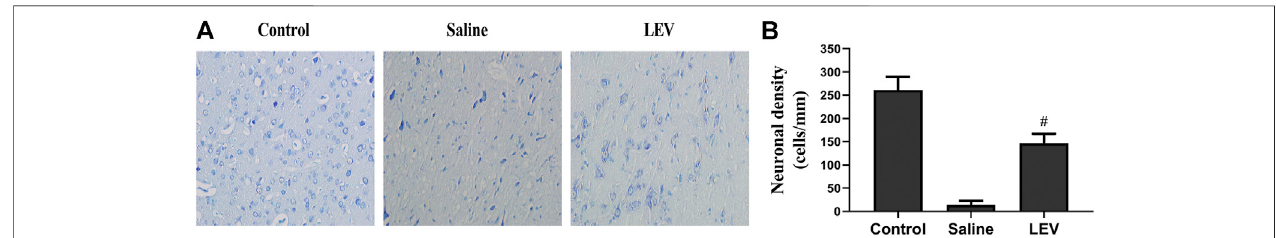
FIGURE3| Levetiracetam(LEV)treatmentaftercerebralinfarctionreducedneuronaldeath. (A) Cresylvioletstainingofthecerebralcortexinthecontrol,saline,and LEV groups (original magni fi cation: × 400). (B) Quanti fi cation of cresyl violet stained cells in the penumbra of the cerebral cortex 14 days after cerebral ischemia. N (cid:1) 12 per group. # p < 0.01 compared to the saline and control